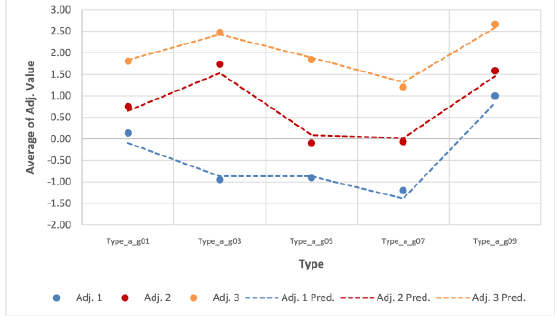
Figure 6. Prediction performance for horizontal color gradients.